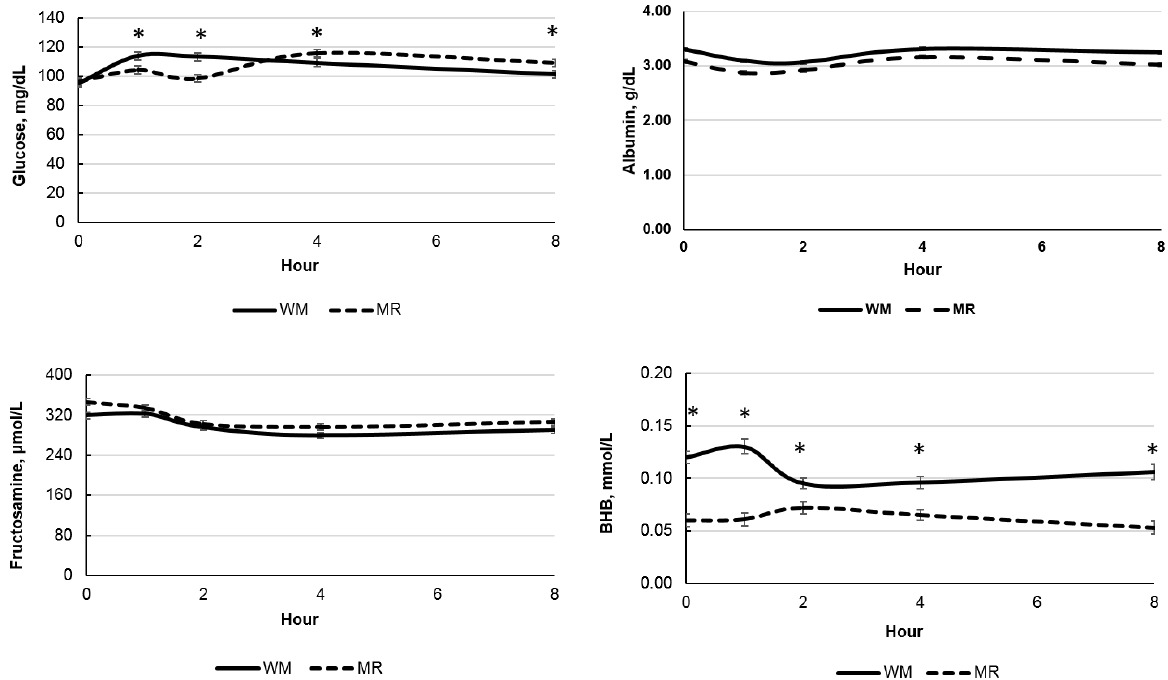
Figure 4. Blood metabolites according to the sampling time of calves fed whole milk (WM) or milk replacer (MR) as liquid diet. * Denotes difference between liquid diet with p < 0.05.